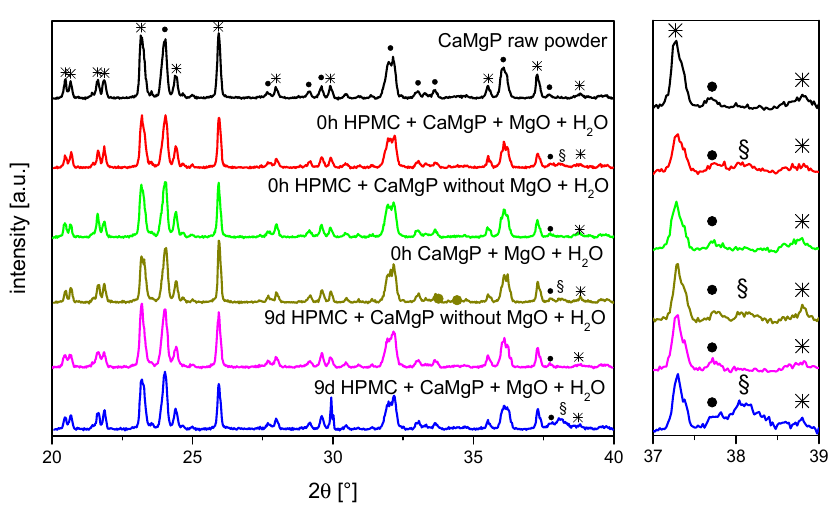
Figure 2. X-ray diffraction patterns of different cement pastes stored for up to 9 d at 37 °C; * farringtonite, • stanfieldite, § most likely brucite.